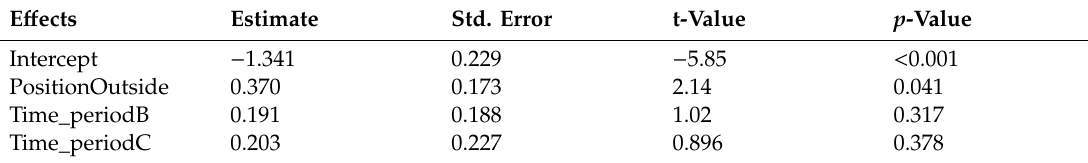
Table 3. Estimated regression parameters (odds ratio), standard errors, t-values, and p -values for the binomial GLMM of proportion of FDp-positive S. titanus with covariates Trap position and Time period and their interaction. The estimated value for σ Vineyard is